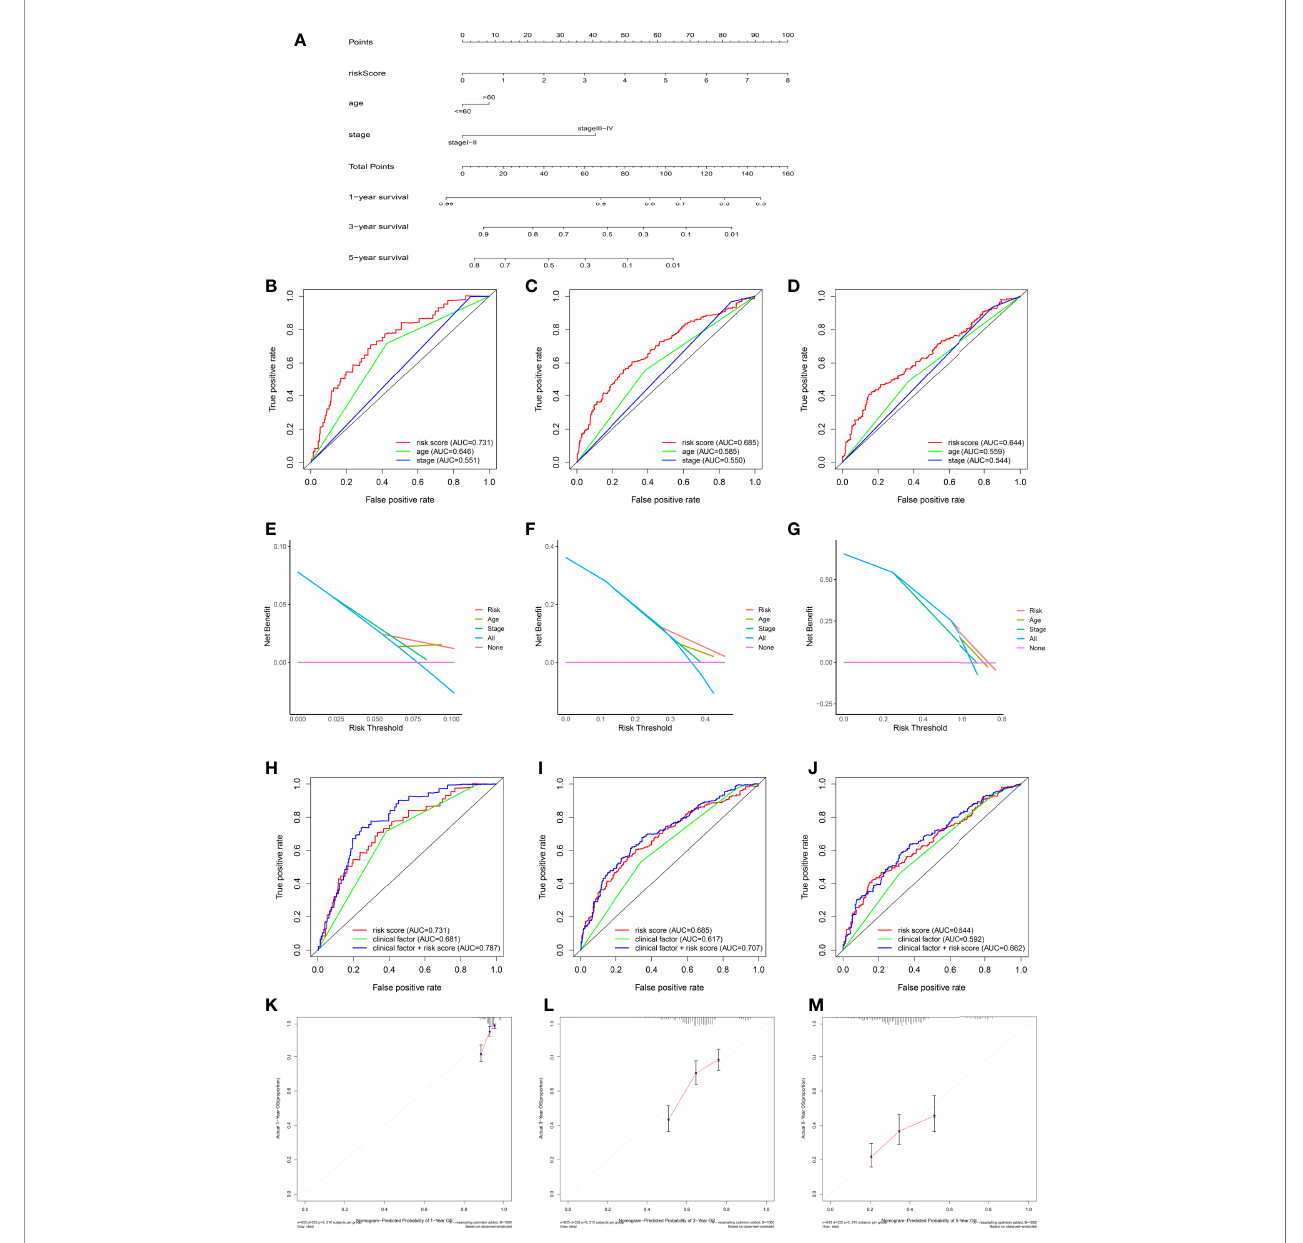
FIGURE 8 | Construction and validation of nomograms. (A) Nomogram for predicting the 1-, 3-, and 5-year overall survival (OS) of ovarian cancer (OC) patients in the training set. (B – D) Receiver operating characteristic (ROC) curve showing the area under the curve (AUC) values of risk, nomogram, age, and stage in predicting survival in OC patients. (E – G) Decision curve analysis of the risk, age, and stage at 1-, 3-, and 5-year OS. The x-axis shows the threshold probability, and the y-axis measures the net bene fi t. (H – J) Receiver operating characteristic (ROC) curve showing the AUC values of risk score, clinical factors, and both sides in predicting survival in OC patients. (K – M) Calibration curves of the nomogram for predicting 1-, 3-, and 5-year